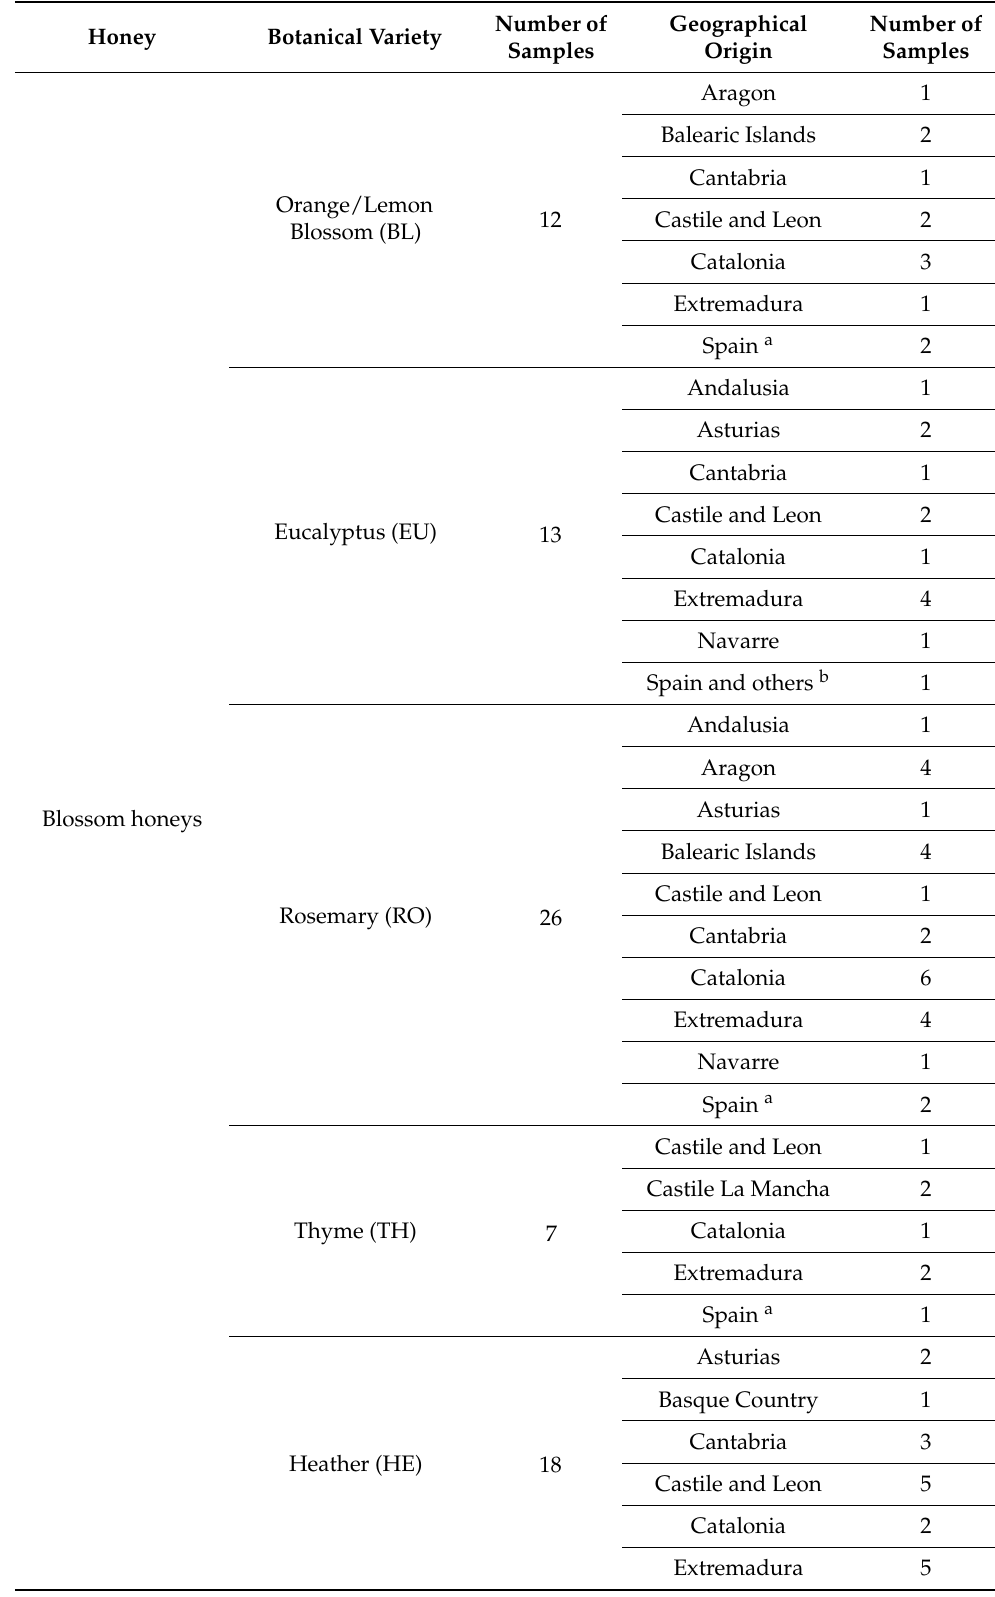
Table 1. Analyzed honey samples considering botanical and geographical